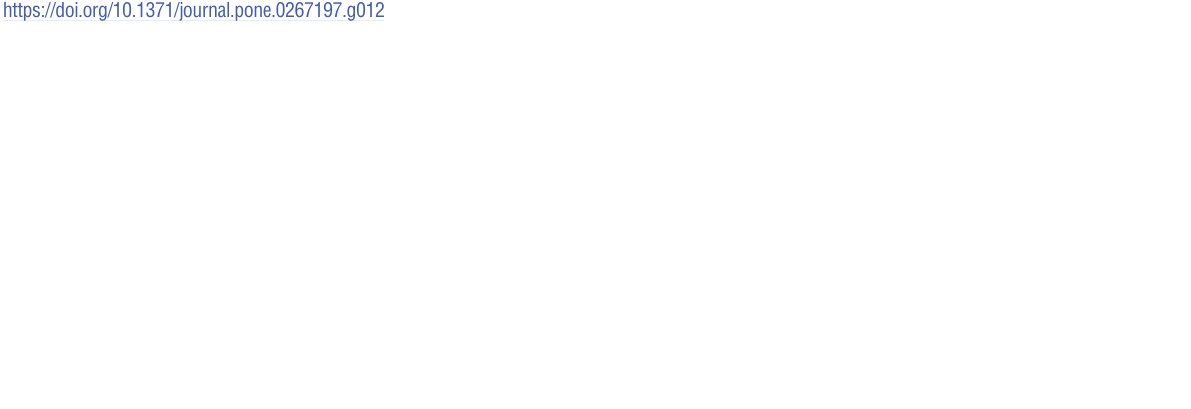
PLOS ONE | https://doi.org/10.1371/journal.pone.0267197 May 2, 2022 17 /